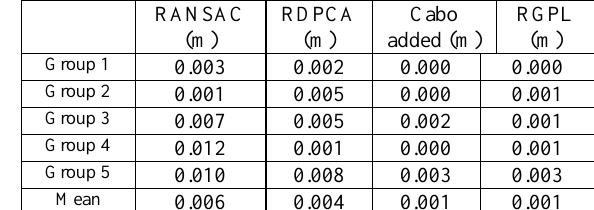
Table 5 Estimated parameters from different segmentations methods